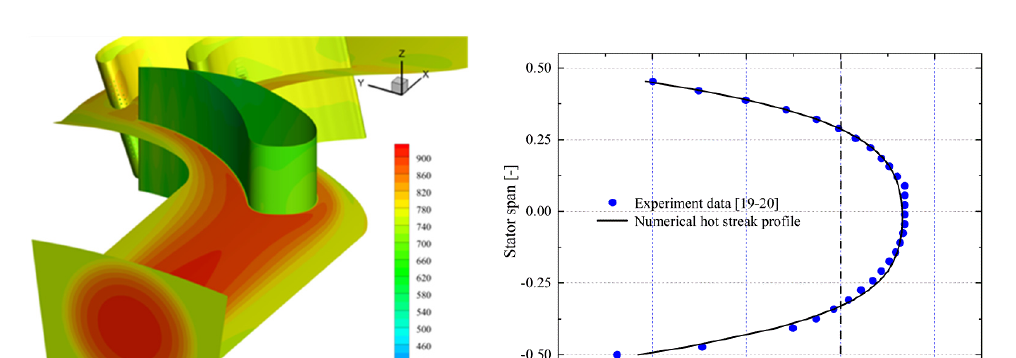
Figure 3. Temperature distribution of the turbine stage. ( a ) Temperature distribution; ( b ) tempera- ture profile.